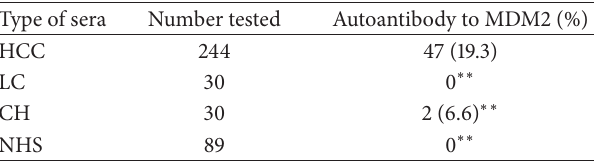
Table 1: Frequency of autoantibody against MDM2 in human sera by ELISA.